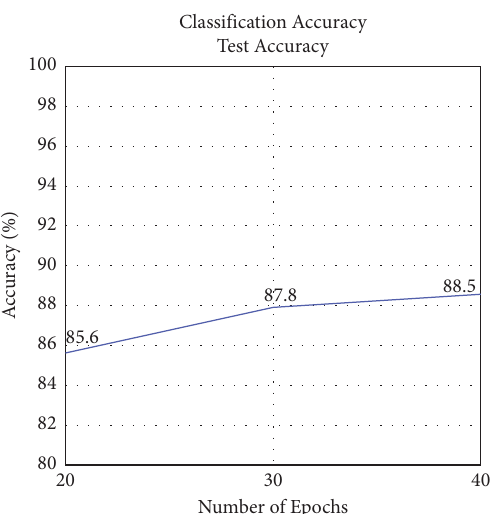
Figure 9: Classifcation accuracy of AlexNet using RmsProp